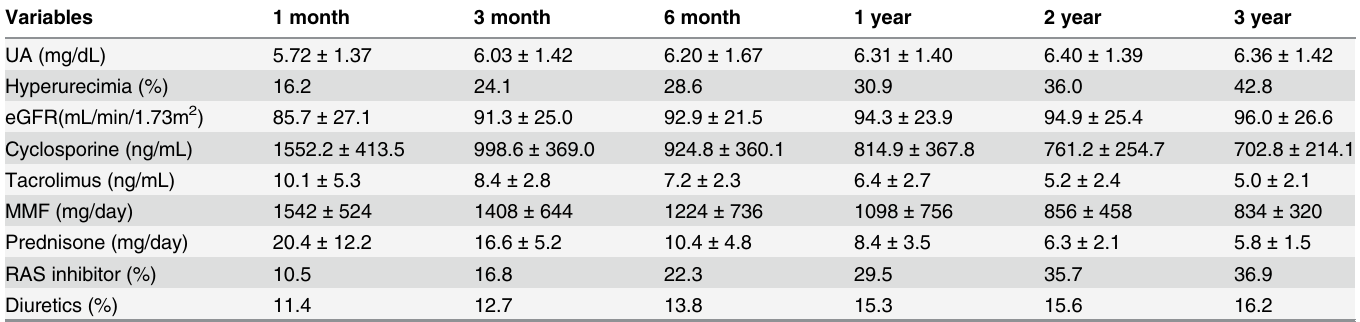
Table 3. Post-transplantvalues of time-dependent variables. Abbreviations as in Table 1. Cyclosporine plasma concentrations are C2 values, also known as the “ peak value ” , which is highly associated with